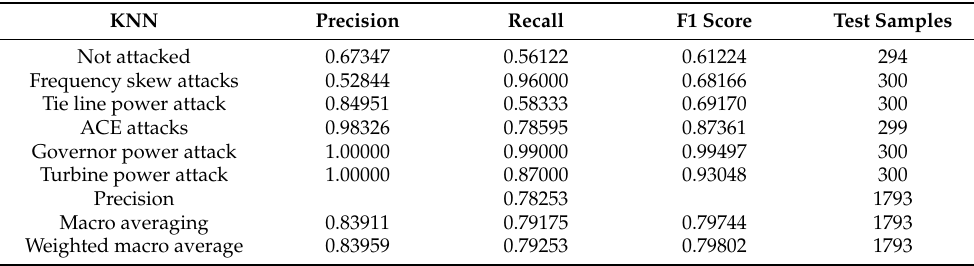
Table A2. The KNN algorithm trained on the model indicator data.